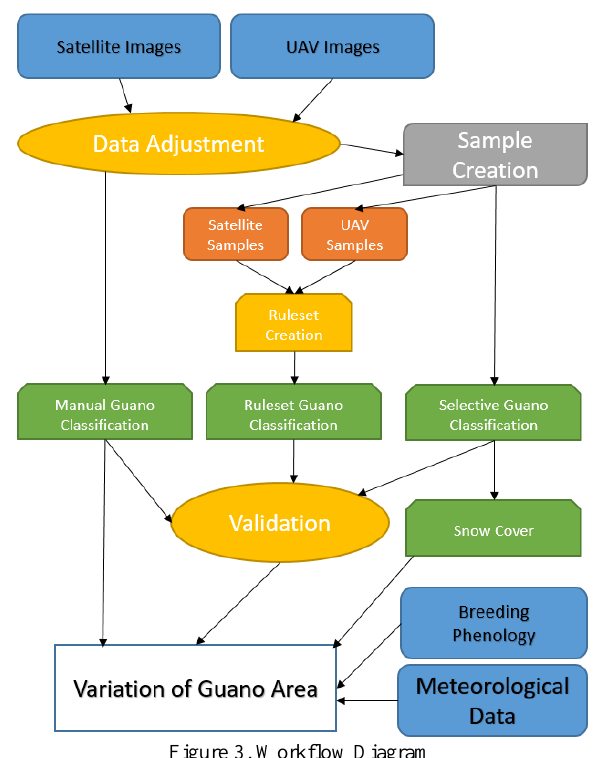
Figure 3. Workflow Diagram